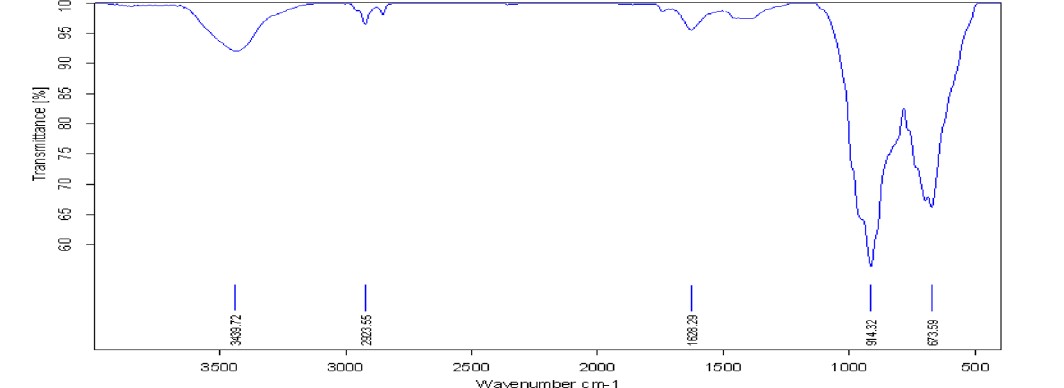
Fig. 7. FT-IR spectrum of Au Nanoparticle (sample